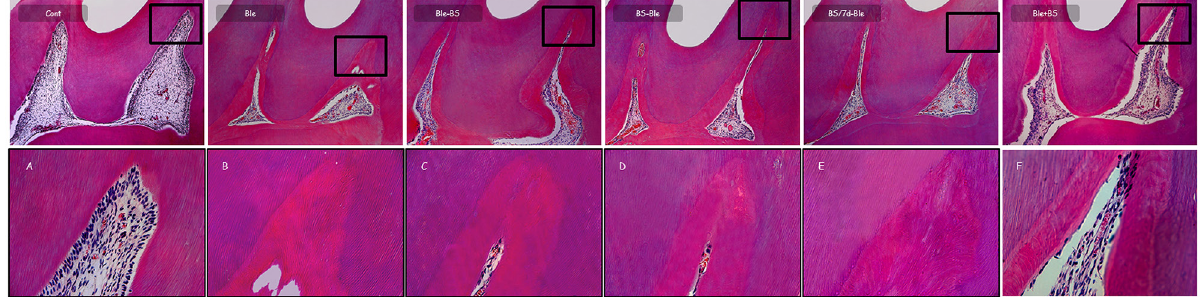
Figure 2- Representative images of the groups at 30 days. Control: cellular and tissue organization (A). Ble (B), Ble-BS (C), BS-Ble (D), BS/7d-Ble (E), Ble+BS (F): absence of inflammation and deposition of tertiary dentin. [100X, 400X;